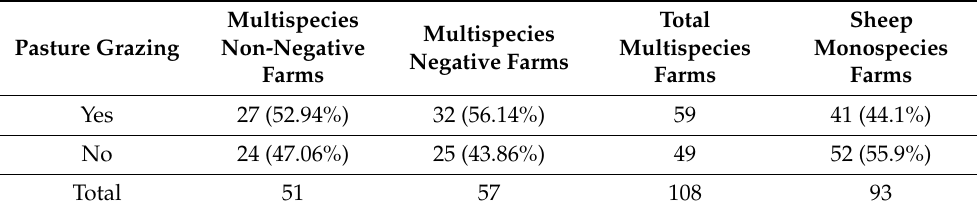
Table 5. Risk factor 1: Results of the association between the traditional practice of seasonal pasture grazing and type of farm.